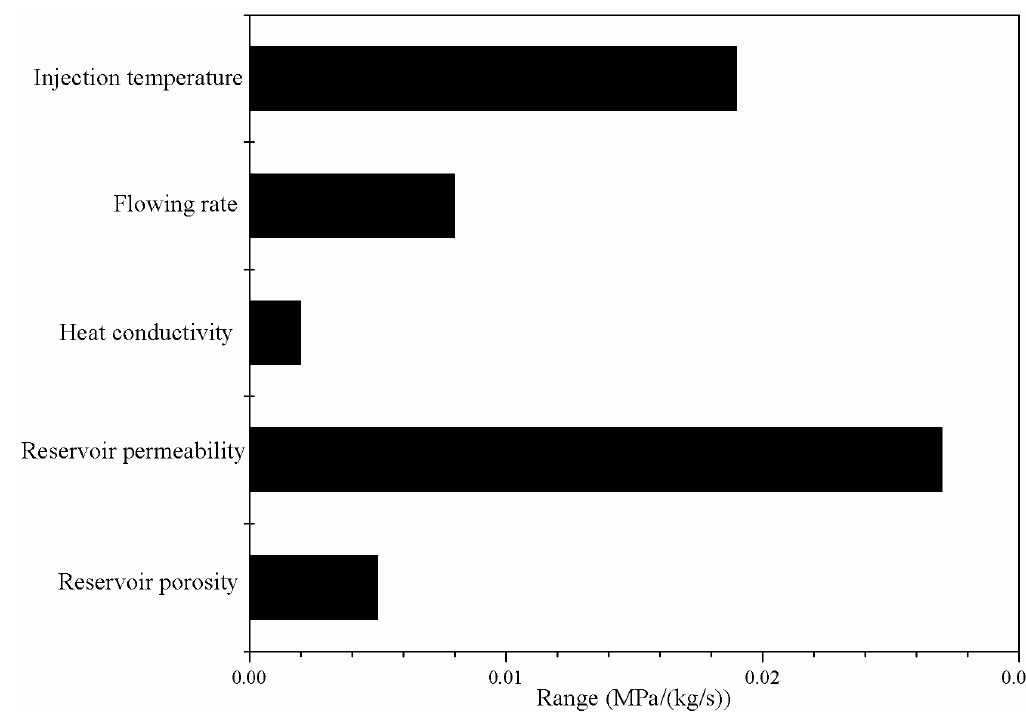
Figure 7. Ranking of the five conditions of the influential effects on the reservoir impedance.